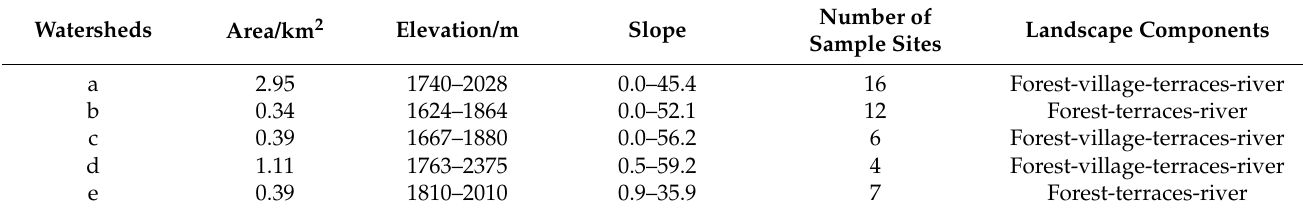
Table 1. Basic information on the five small